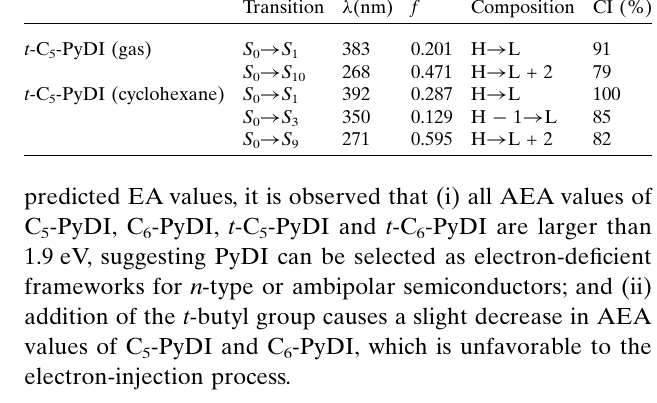
Table 4 VIPs, AIPs, VEAs and AEAs calculated at the B3LYP/6-311** level (eV). Molecules